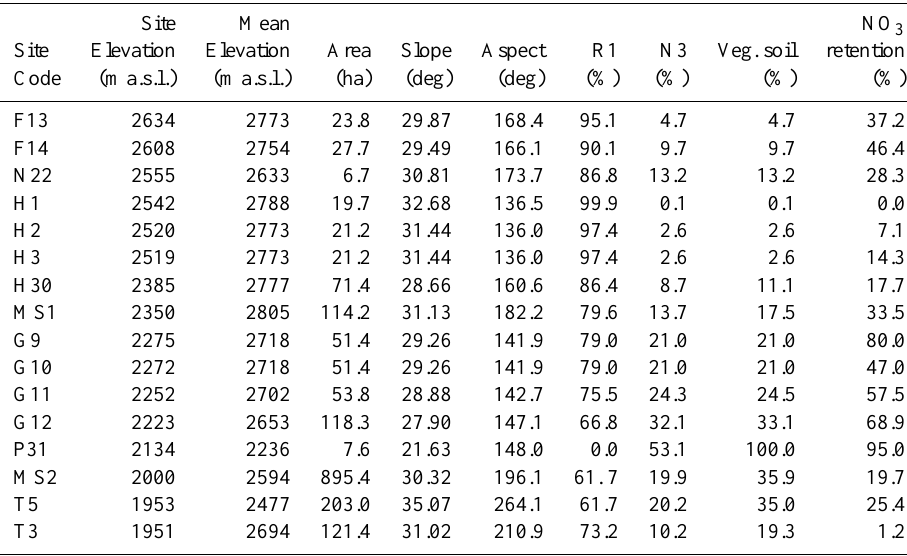
Table 2. Physical features and estimate of NO 3 retention (%) of study sites. R1, N3 and Veg. soil are expressed as percentage of the catchment area.